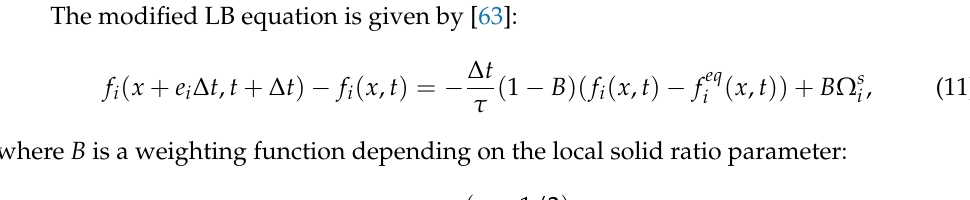
Figure 2. The definition of solid ratio parameter, γ , in the Immersed Moving Boundary (IMB) method.